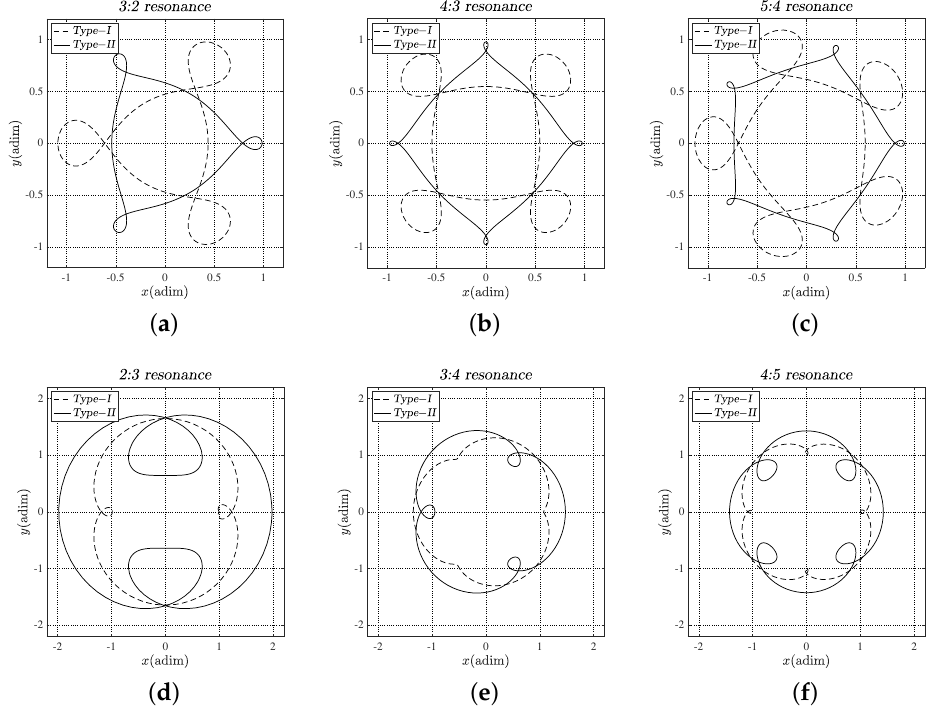
Figure 2. Example resonant periodic orbits in the Sun–Earth system ( µ SE ): ( a ) 3:2 resonance; ( b ) 4:3 resonance; ( c ) 5:4 resonance; ( d ) 2:3 resonance; ( e ) 3:4 resonance; ( f ) 4:5